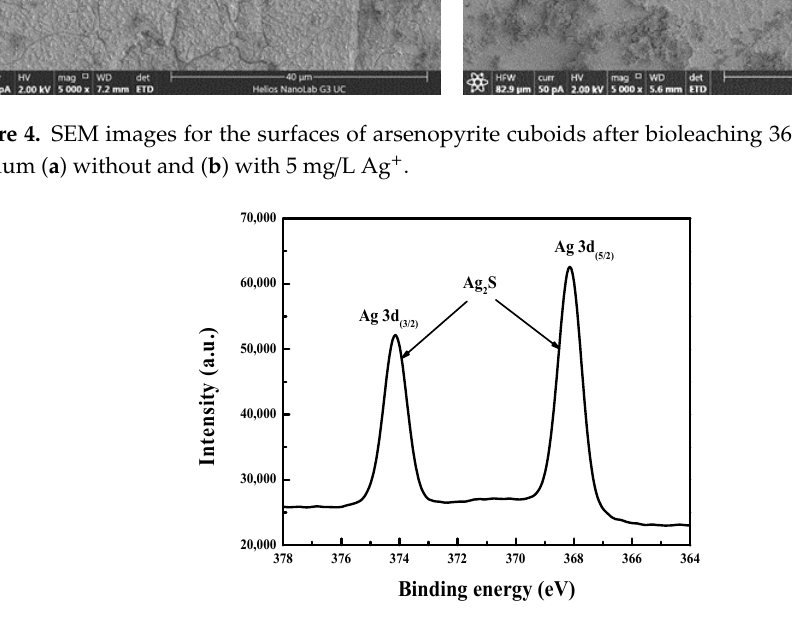
Figure 5. XPS spectrum of Ag 3d for the surface of arsenopyrite cuboid after bioleaching 36 h in 9K culture medium with 5 mg/L Ag + .